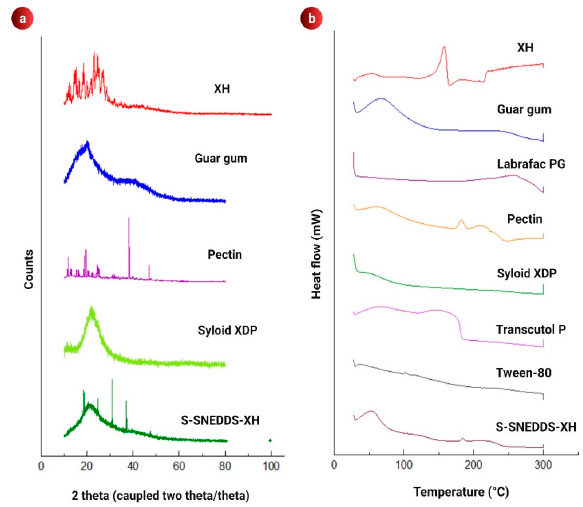
Figure 2. Results showing ( a ) overlay plot of PXRD patterns of XH, excipients and S-SNEDDS formulation; ( b ) DSC thermograms of XH, excipients and S-SNEDDS formulation.